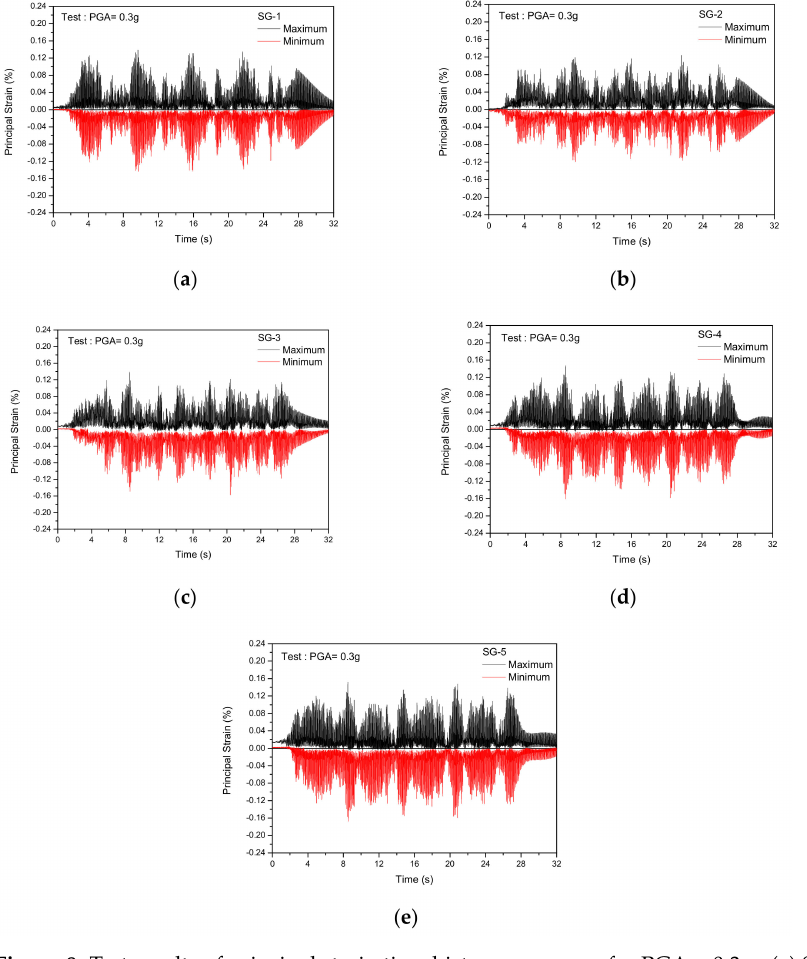
Figure 8. Test results of principal strain time history responses for PGA = 0.3 g: ( a ) SG-1; ( b ) SG-2; ( c ) SG-3; ( d ) SG-4; ( e )